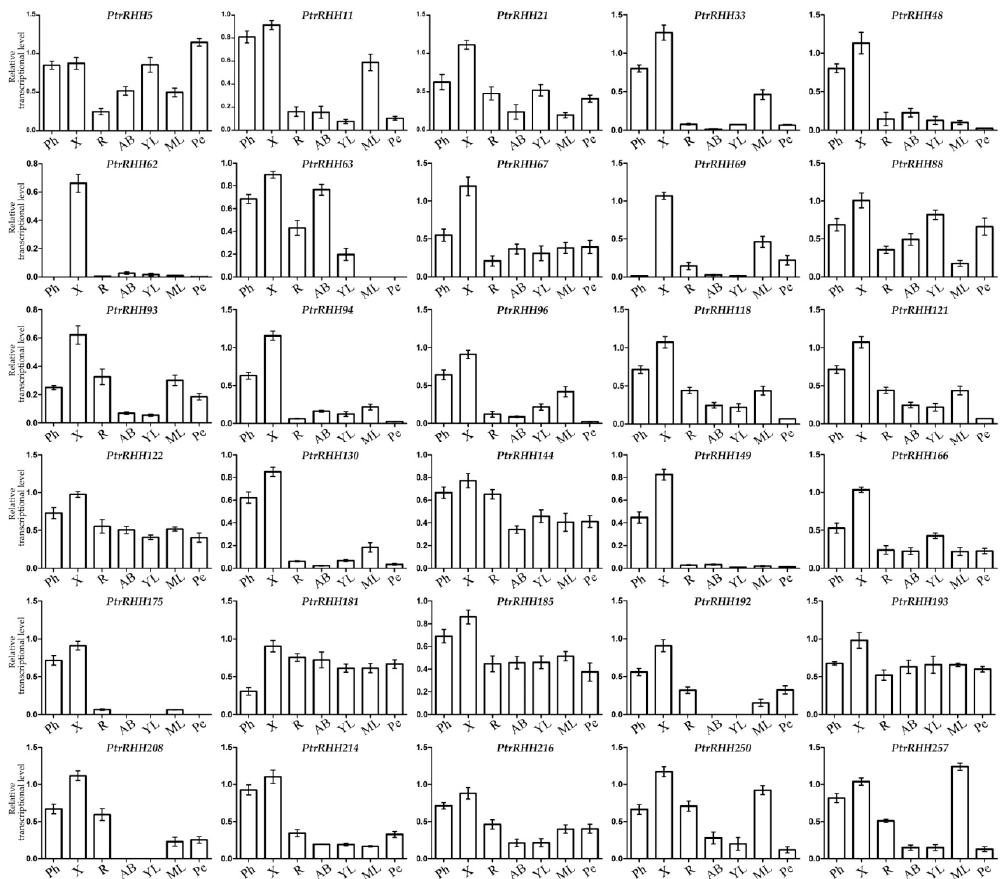
Figure 4. Transcription levels of 30 RING-H2 genes in various tissues of three-month-old young trees using qRT-PCR analysis. The PtrActin 2 gene was used as control. Ph, phloem; X, xylem; R, root; AB, apical bud; YL, young leaf; ML, mature leaf; Pe, petiole.